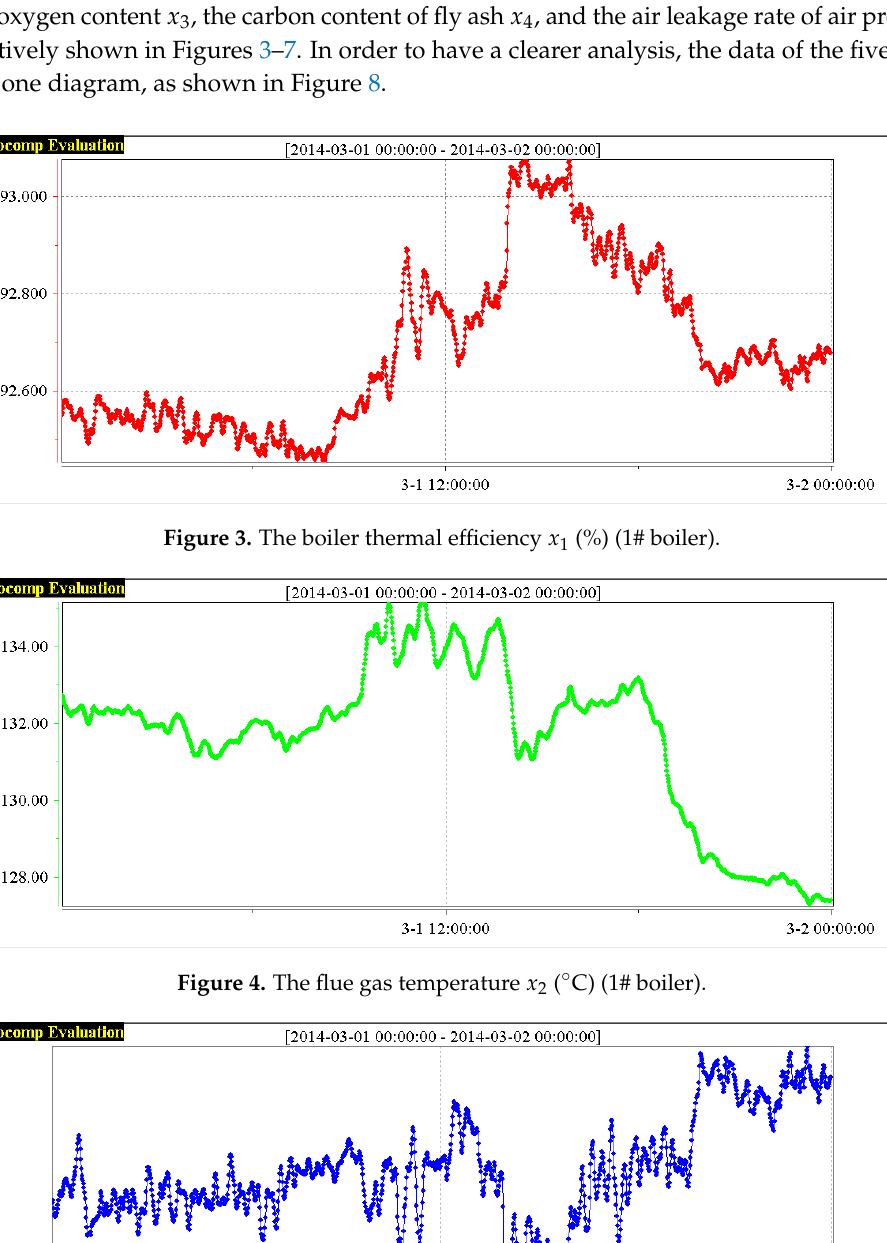
x (%) (1# boiler). x (%) (1# boiler). 3 3